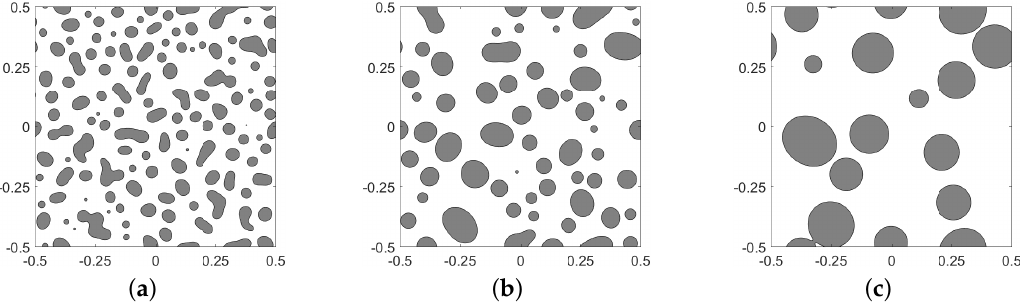
Figure 10. ( a – c ) are the snapshots of numerical solutions of the CH equation with the initial condition (40) at t = 100 ∆ t , 500 ∆ t , and 2500 ∆ t ,